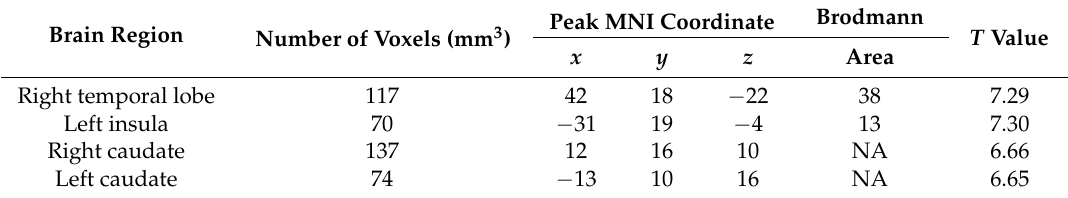
Table 4. The decreased volumes of GM in CI patients compared with the CP group ( p FWE correction < 0.05).